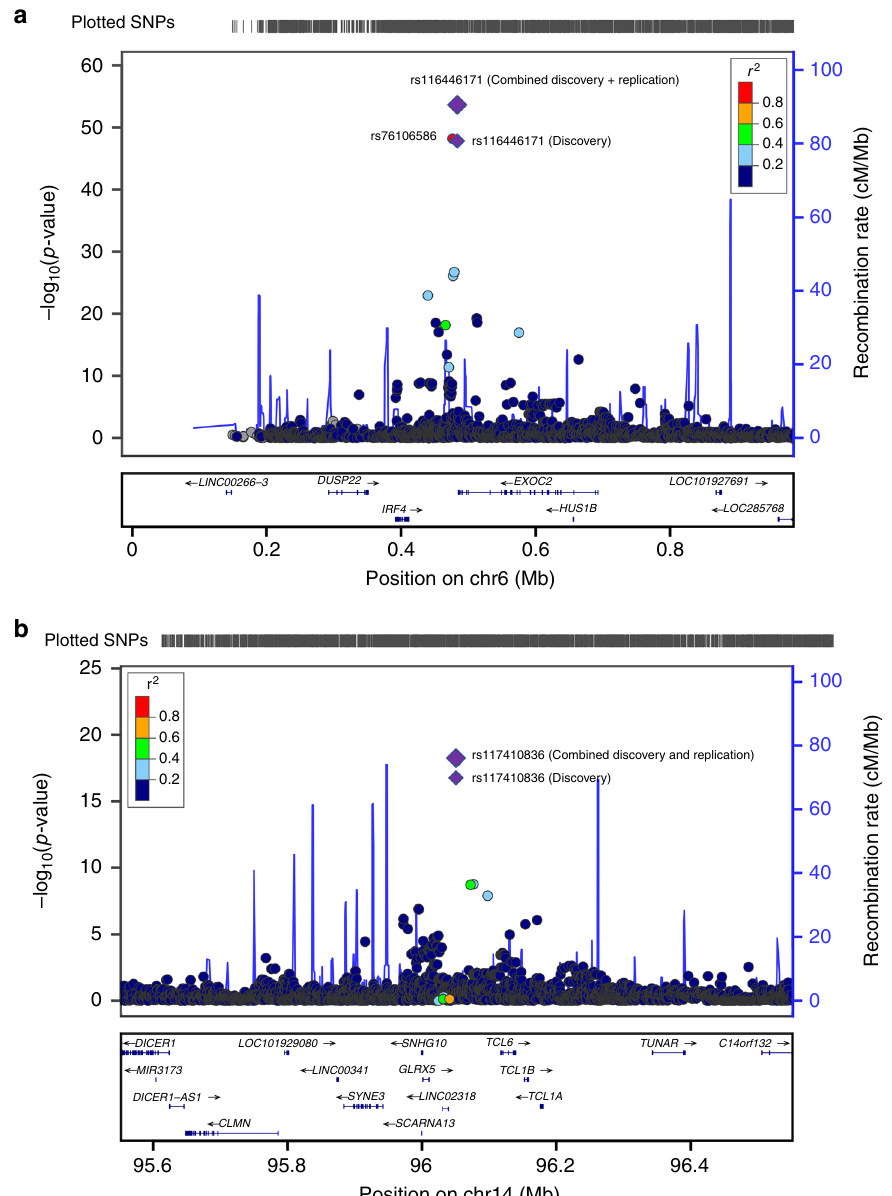
Fig. 1 Regional association plots of two SNPs associated with the risk of WM/LPL. a Chromosome 6p25.3 (rs116446171) and b chromosome 14q32.13 (rs117410836). Shown are the − log 10 association P -values from the discovery log-additive genetic model for all SNPs in the region (dots) and combined discovery and replication fi xed-effects analysis (diamonds). The lead SNPs are shown in purple, with results from both the discovery (small diamonds) and combined (large diamonds) analyses. Estimated recombination rates (from 1000 Genomes) are plotted in blue. The SNPs surrounding the most signi fi cant SNP are color-coded to re fl ect their correlation with this SNP. Pairwise r 2 values are from 1000 Genomes European data. Locations of recombination hotspots are depicted by peaks corresponding to the rate of recombination. Genes, position of exons and direction of exons and direction of transcription from UCSC genome browser (http://genome.ucsc.edu) are denoted. Plots were generated using LocusZoom